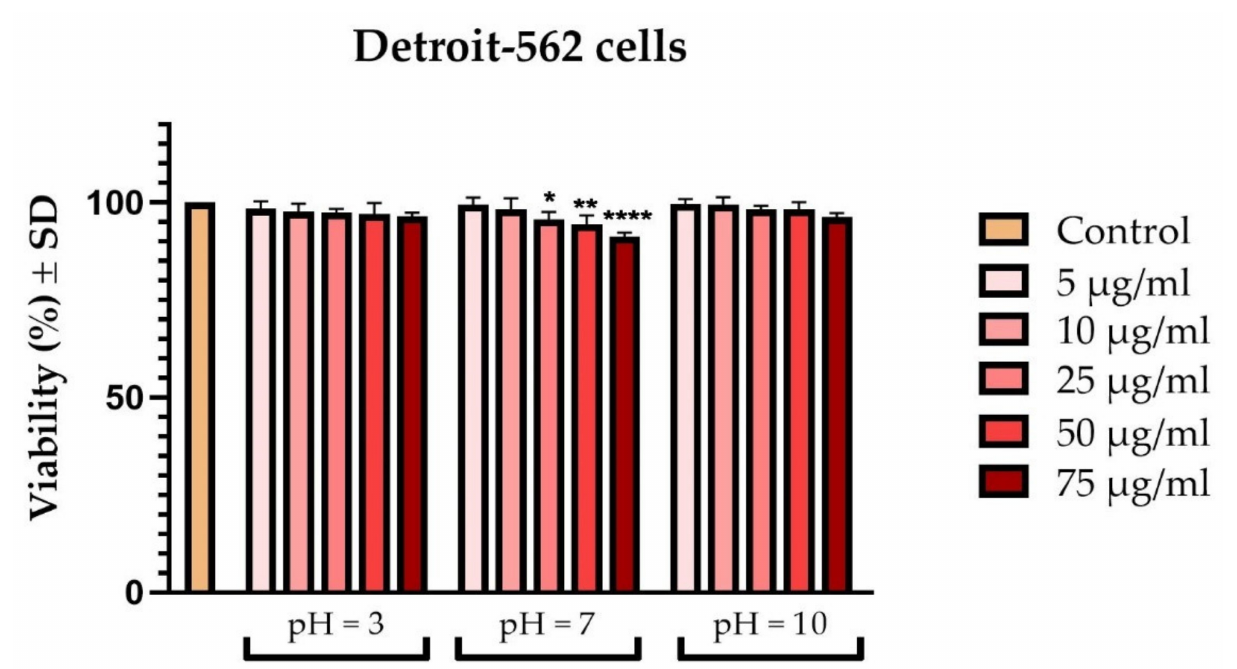
Figure 2. In vitro evaluation of the effect of P2 (5, 10, 25, 50, and 75 µ g/mL) suspended in artificial saliva with acidic pH (pH = 3), neutral pH (pH = 7), and basic pH (pH = 10) at the Detroit-562 cell line level after 72 h of treatment. The results are expressed as viability percentages (%) normalized to control cells (unstimulated) and expressed as mean values ± SD of three independent experiments performed in triplicate. The statistical difference between the control group and the P1-treated group was determined by applying one-way ANOVA analysis, followed by Dunnett’s multiple post-test comparisons (* p < 0.05; ** p < 0.01; **** p <